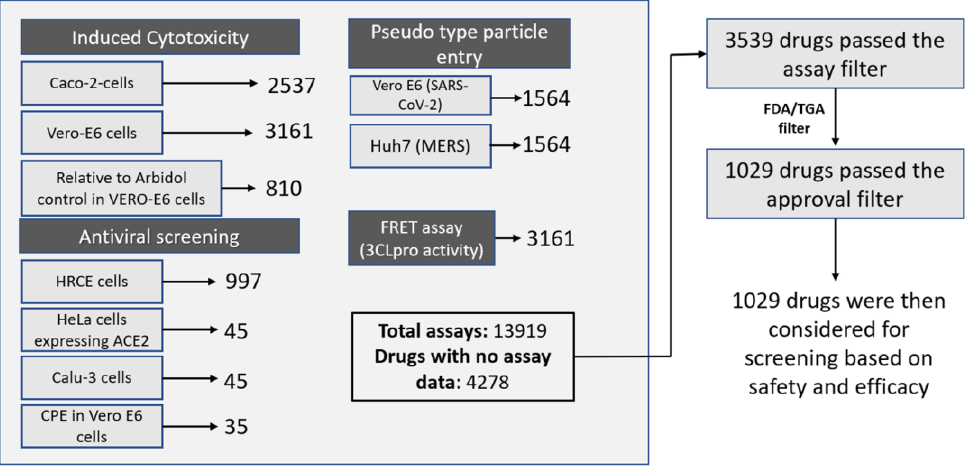
Figure 3. Antiviral assay data and number of drugs that passed each filter.